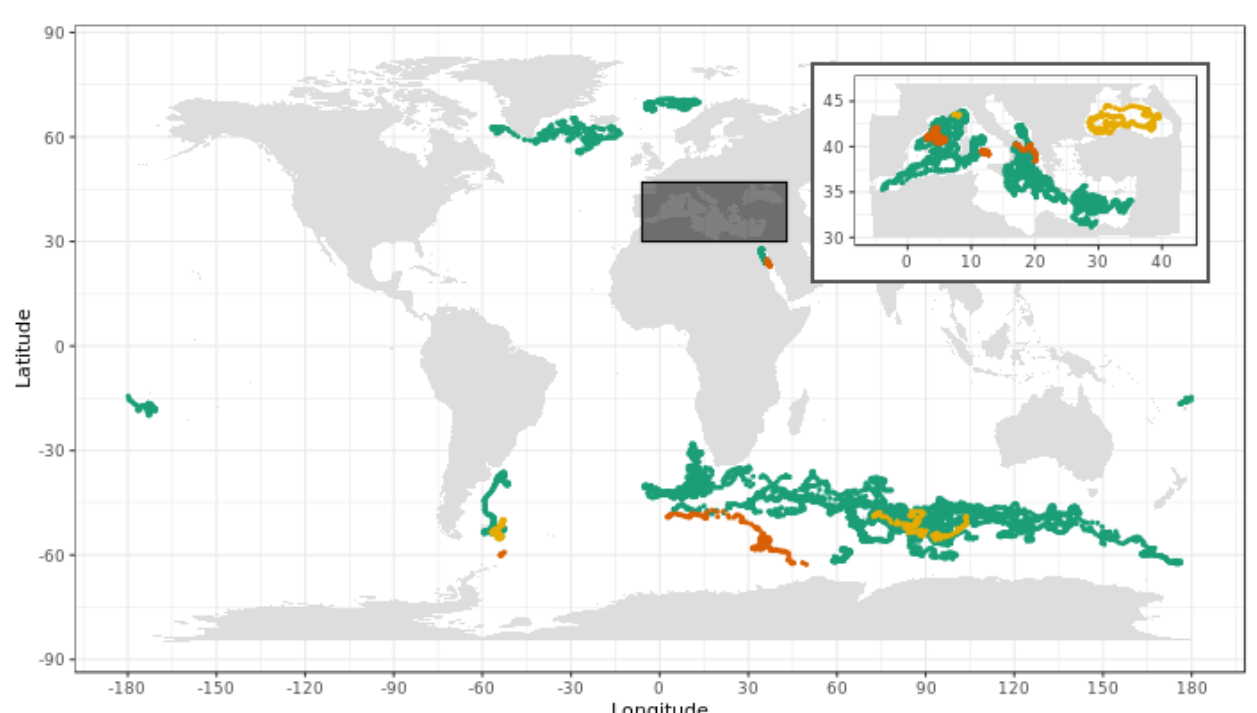
Figure 8. Radiometry profiles acquired by the 55 BGC-Argo floats with ancillary night profiles and drift measurements. Green dots: successfully corrected profiles with the DM-QC procedure; Orange dots: uncorrected profiles; Yellow dots: profiles corrected with alternative methods (see Supplementary Materials Section S2).